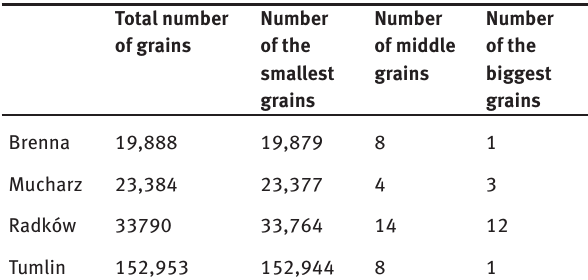
Figure 12: Comparison between two scaled different components of kinetic energy ( E energy) plotted as a function of strain: (A) Brenna, (B) Mucharz, (C) Radków, (D) Tumlin. Table 5: Number of grains after